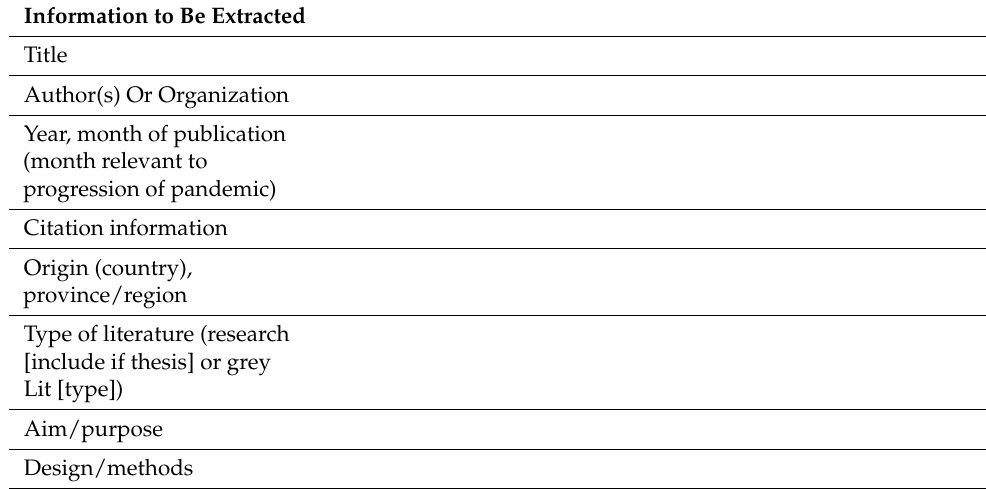
Table A5. Extraction